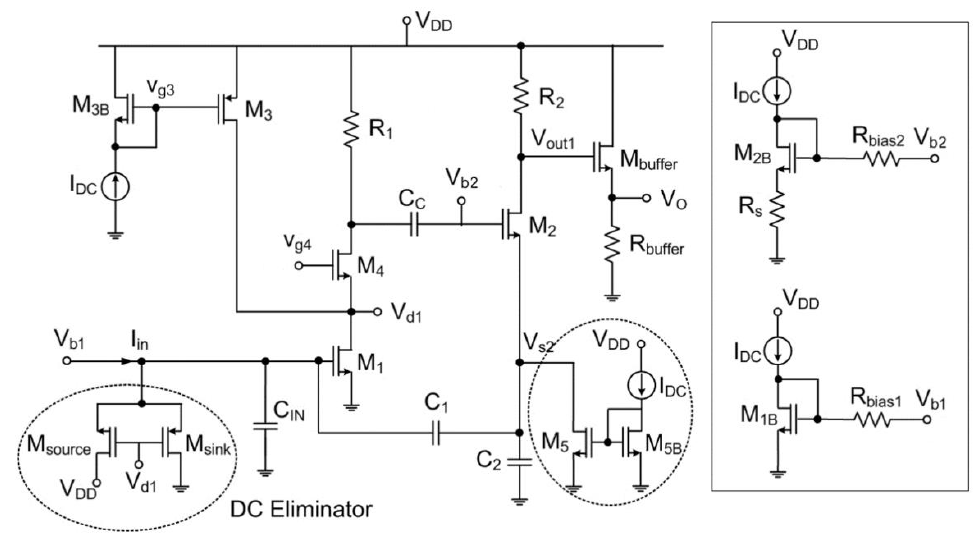
Fig. 3. The implementation of the amplifier circuit with associated bias circuits and the output